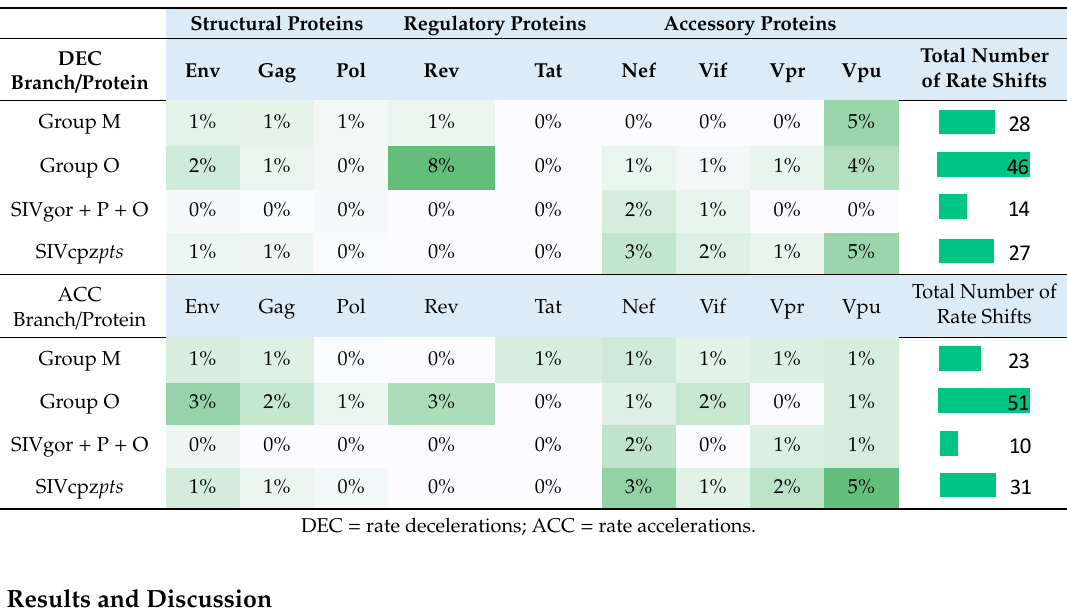
Table 1. The proportion of rate shifts (rate decelerations and rate accelerations in upper panel and lower panel, respectively) detected in each of the major branches of the phylogeny, relative to the protein size. The right-most column shows the absolute number of rate shifts detected in the branch. Cell background color intensity increases with the proportion of rate shifts.